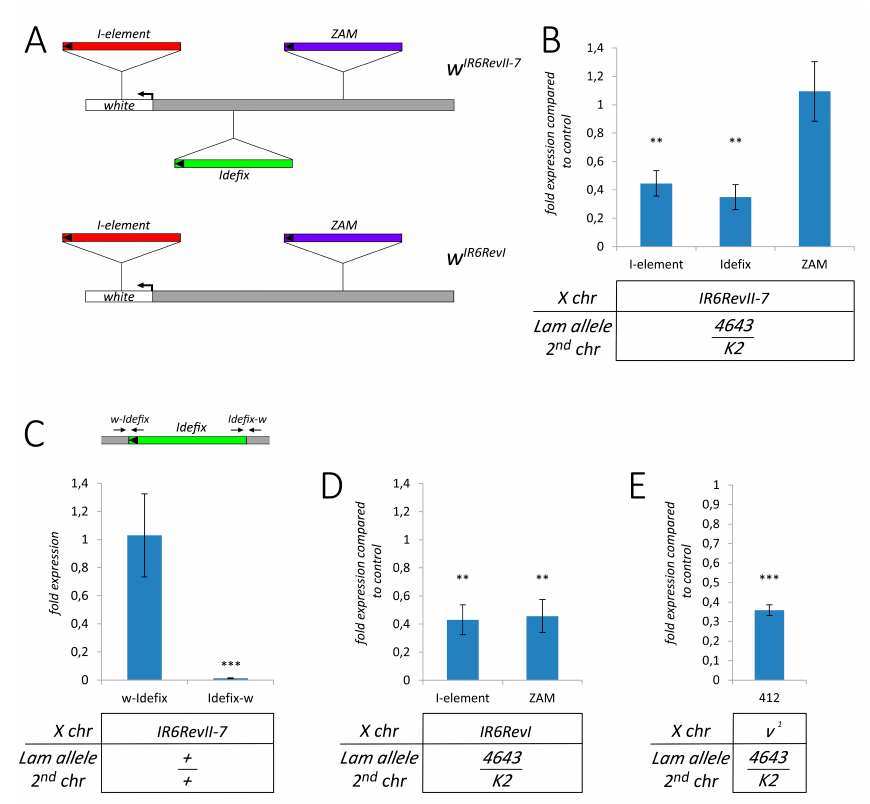
Figure 3. Silencing of euchromatic retrotransposons in somatic tissues of Lam mutant flies. ( A ) Schematic representation of the structure of the w IR6RevII7 and w IR6RevI alleles. The I-element (5.4 kb in length) is located in the first intron of the w gene. The Idefix element (7.4 kb in length) is located at about 1660 bp from the w transcription start site. The ZAM element (9 kb in length) is located at about 3 kb from the w transcription start site in the w IR6RevI allele, and more than 10 kb in the w IR6RevII7 alleles. Transcription orientation is indicated by arrows. ( B – E ) qRT-PCR analysis of some specific retrotransposons in RNAs isolated from female head tissues. Data are mean values from three independent experiments, and error bars indicate SD (** P < 0.01; *** P < 0.005). ( B ) I-element , Idefix , and ZAM expression in Lam 4643 / Lam K2 mutants (4643 / K2) compared to control flies ( +/+ ) in the w IR6RevII7 mutant background. ( C ) Upper part: schematic representation of the genomic region containing the 5 (cid:48) upper region of the white gene (grey) where the Idefix element (green) is inserted. The two qPCR couples of primers are represented by black arrows (see Table S1). Lower part: expression of the regions containing the boundaries between Idefix and the white 5 (cid:48) regions in w IR6RevII7 mutants. w-Idefix is the amplicon containing the boundary between the white 5 (cid:48) untranscribed regions and Idefix , while Idefix-w is the amplicon containing the boundary between Idefix and the genomic region that separates Idefix from ZAM . ( D ) I-element and ZAM expression in Lam 4643 / K2 mutants (4643 / K2) compared to control flies ( +/+ ) in the w IR6RevI mutant background. ( E ) Expression of the 412 retrotransposon in Lam 04643 / K2 mutants compared to the Lam +/+ in the v 1 mutant